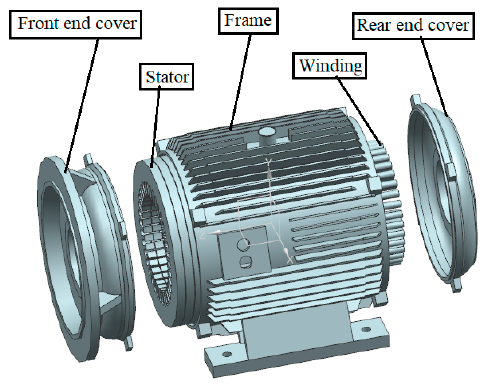
Figure 15. 3D structure model of a motor.